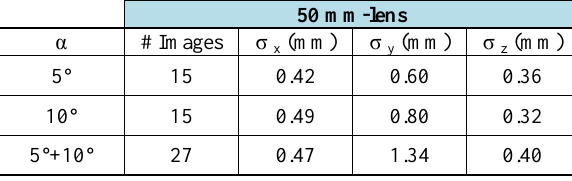
Table 3. Accuracy assessment of the orientation phase (ISO 1